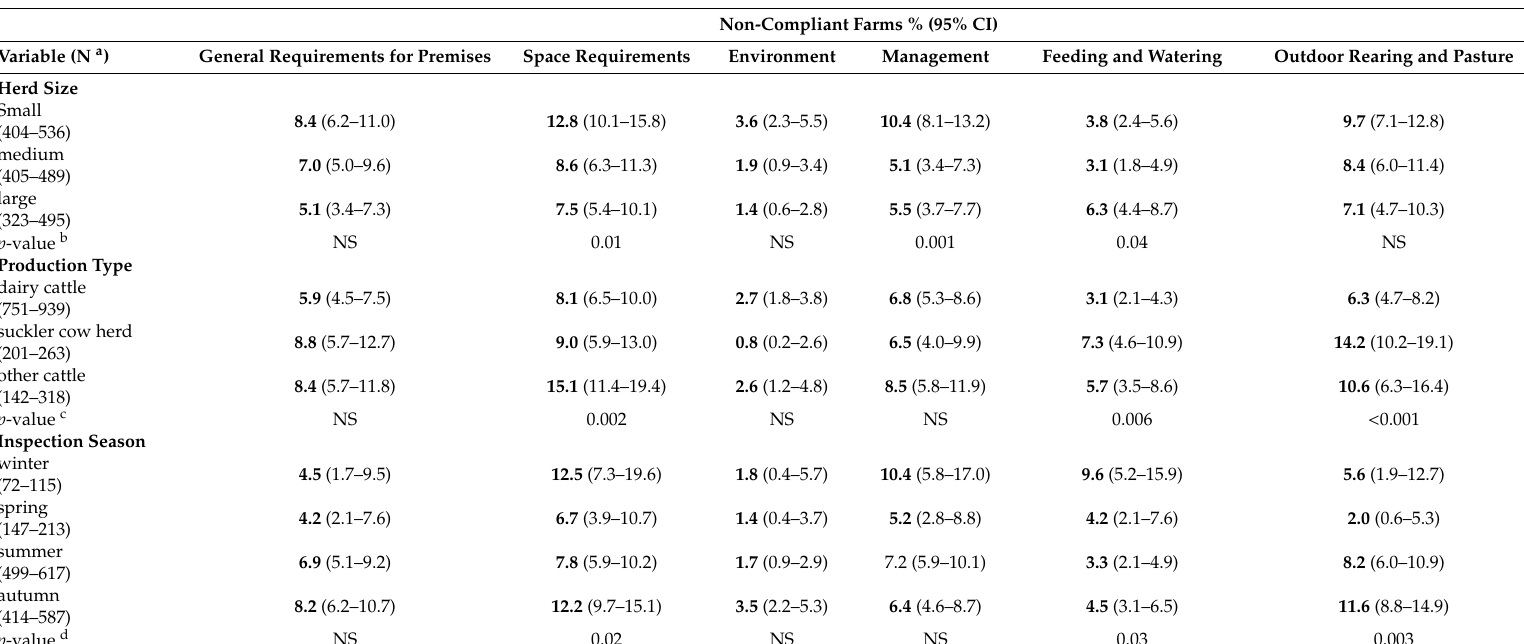
Table 5. Percentage of non-compliant cattle farms in di ff erent main welfare categories concerning adult cattle, divided by herd size, production type and inspection